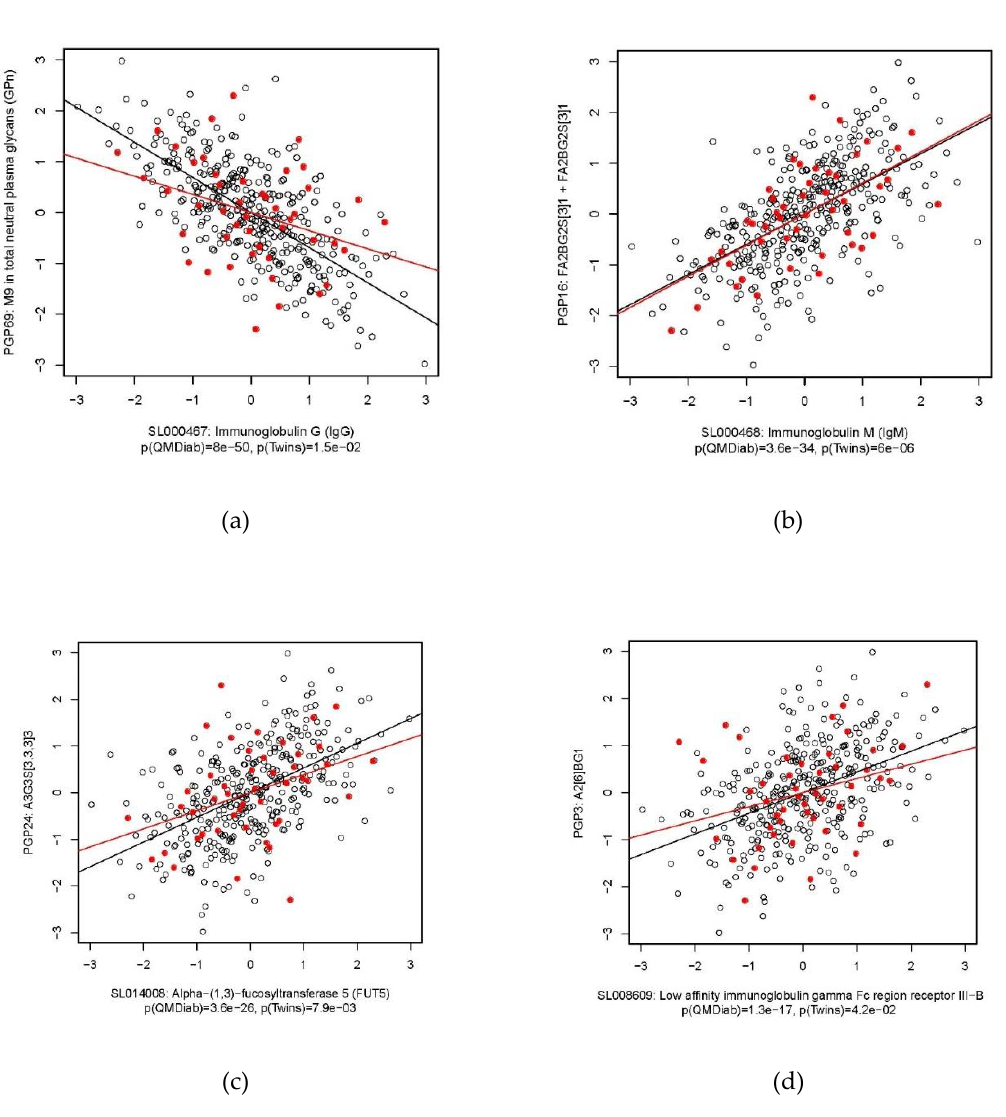
Figure 2. Scatterplots of selected protein–glycan associations. QMDiab (black circles), TwinsUK (red dots); ( a ) IgG with percentage of M9 in total neutral plasma glycans, ( b ) IgM with FA2BG2 glycans, ( c ) FUT5 with A3G3S(3,3,3)3 glycans, and ( d ) FCGR3B with A2(6)BG1 glycans. Table 1. Selected protein–glycan associations. Pearson correlations between inverse-normal scaled traits and corresponding p -values are listed.